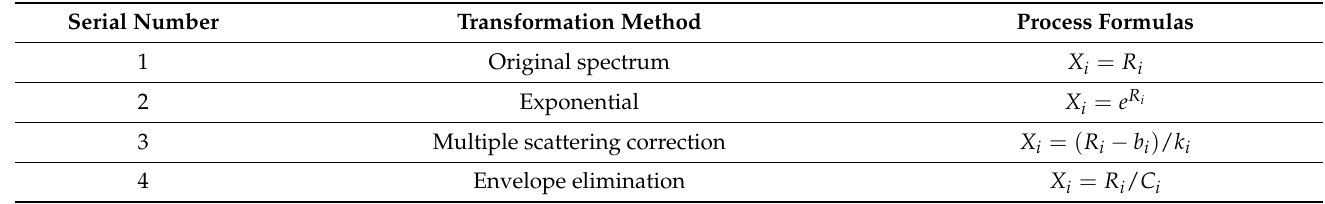
Figure 3. Canopy reflectance data of 20 mangrove sampling points collected by hand-held spec- trometer.